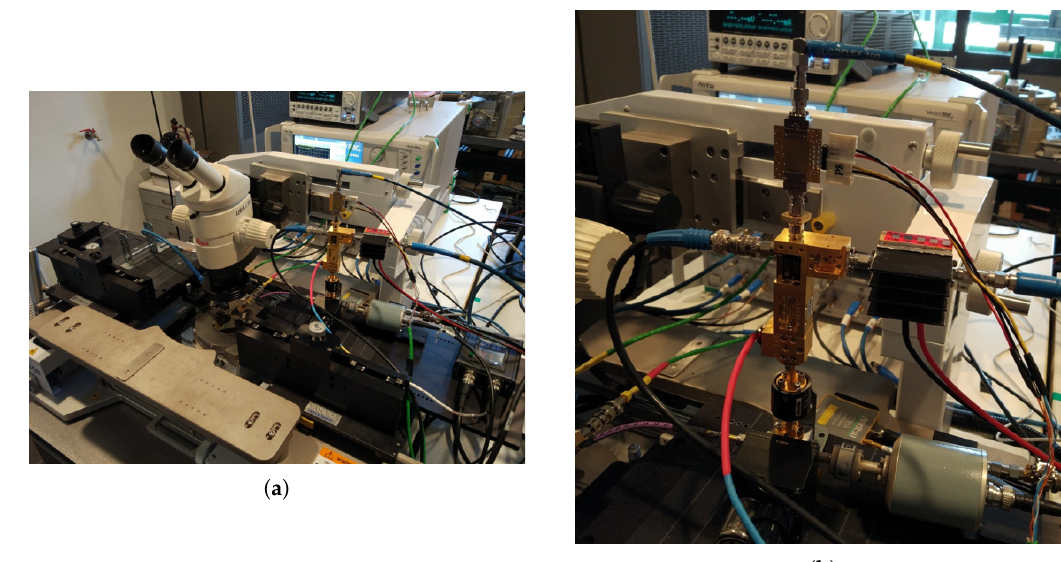
Figure 7. V-band cold-source noise test bench: ( a ) Full view ( b ) Detail of the switch and down-conversion section.